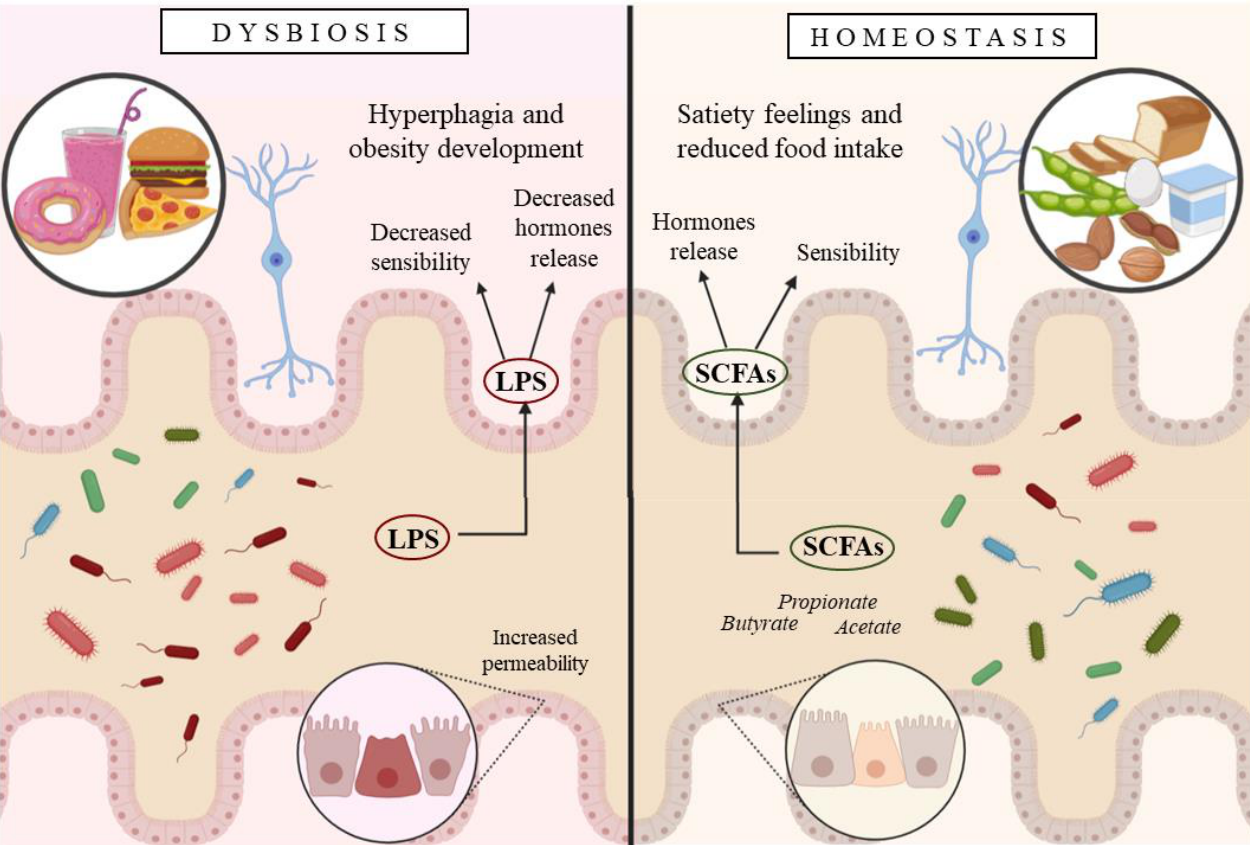
Figure 3. Scheme illustrating the mechanism through which the gut microbiota affects the host.